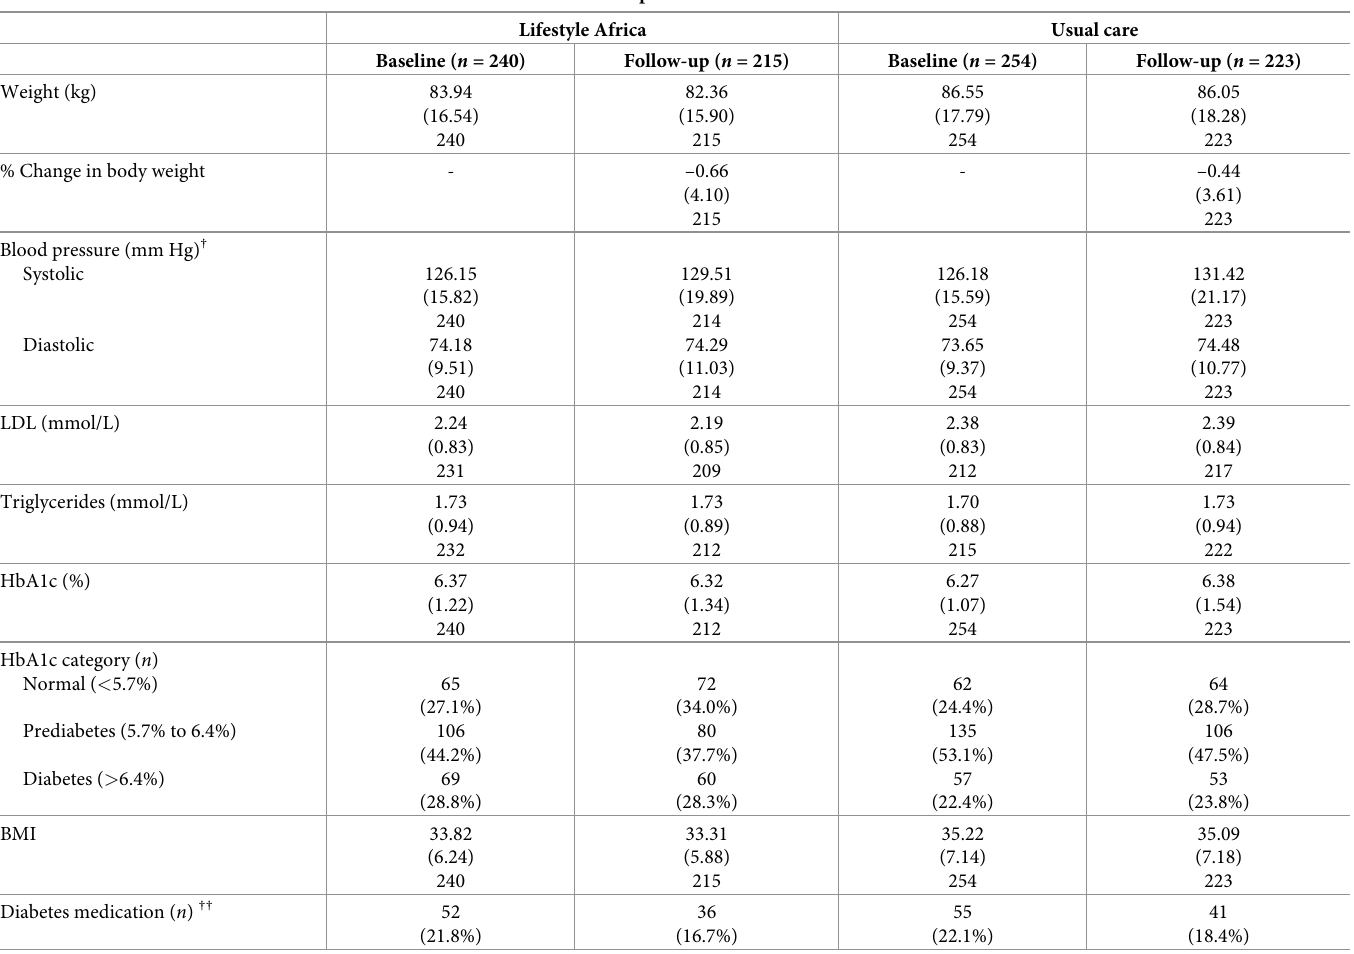
Table 2. Raw data for biometrics and medication use at baseline and